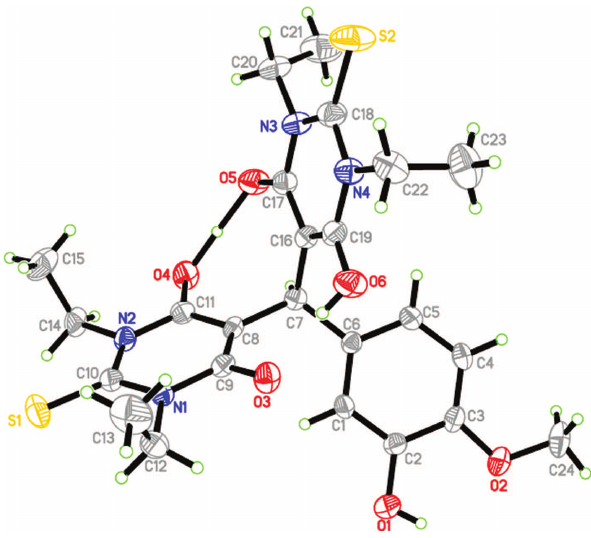
Table 1: Data collection and handling.